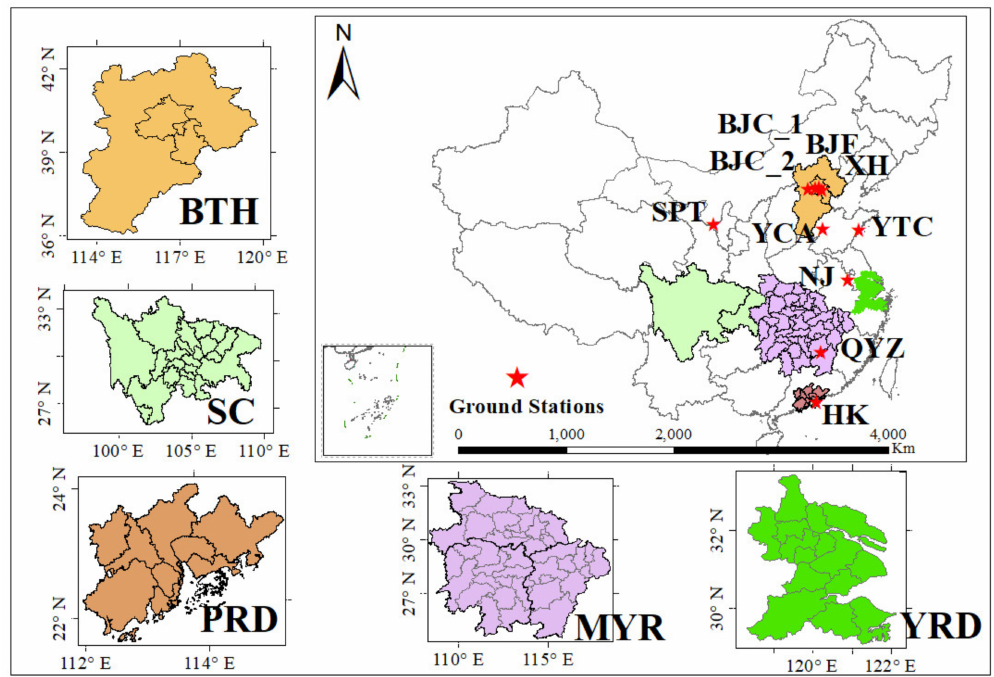
Figure 1. The locations of the five regions in China: Beijing–Tianjin–Hebei (BTH), Sichuan–Chongqing (SC), Pearl River Delta (PRD), Yangtze River Delta (YRD), and Middle Yangtze River (MYR), and the location of the ground_measured aerosol optical depth